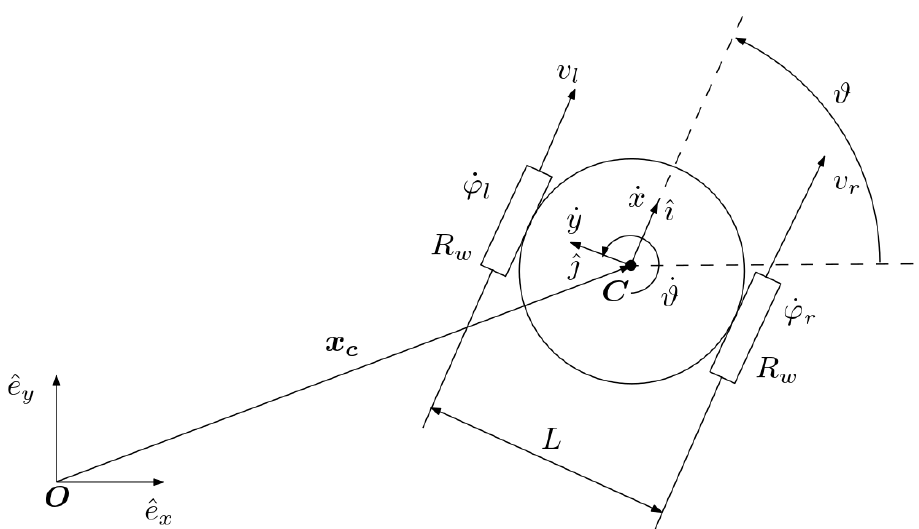
Figure 1. Kinematic model of a differential drive mobile robot, with focus on the relation between the robot’s frame and the inertial